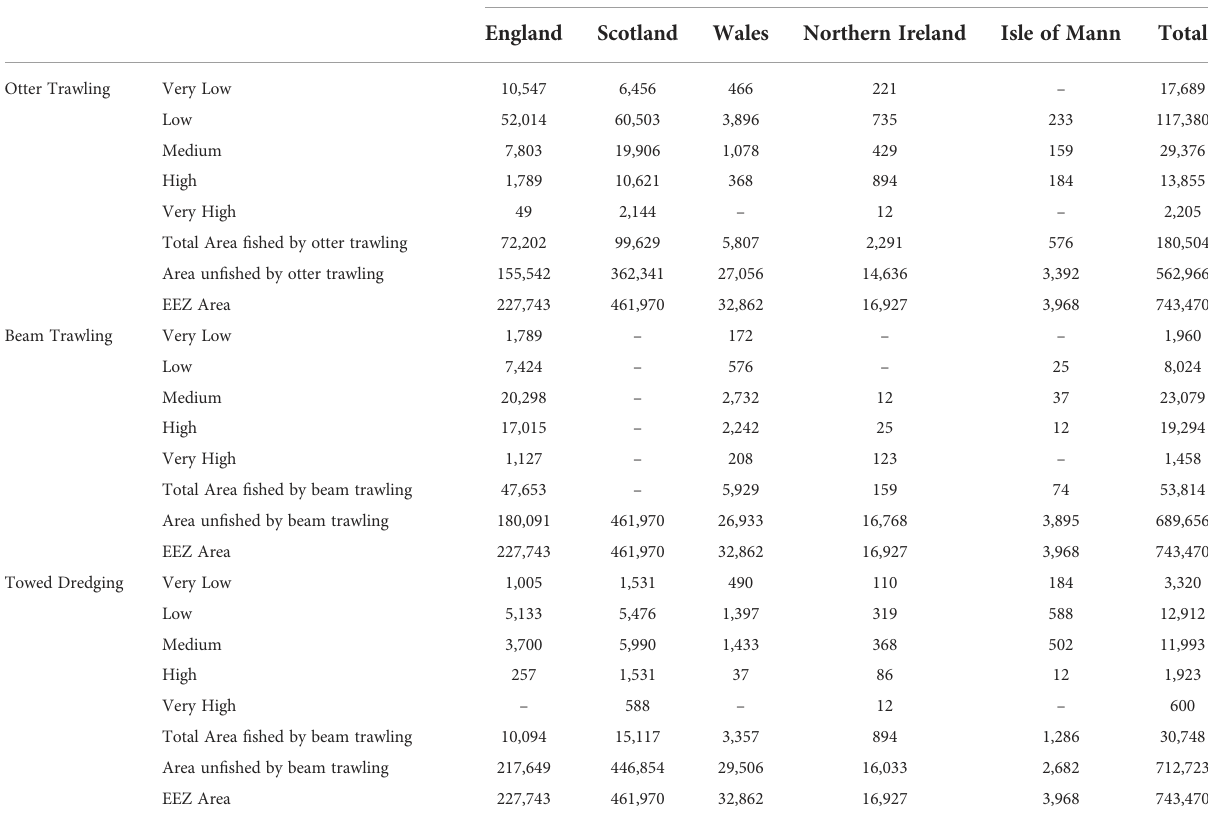
TABLE 2 Spatial area coverage of the carbon vulnerability ranking (CVR) by fi shing